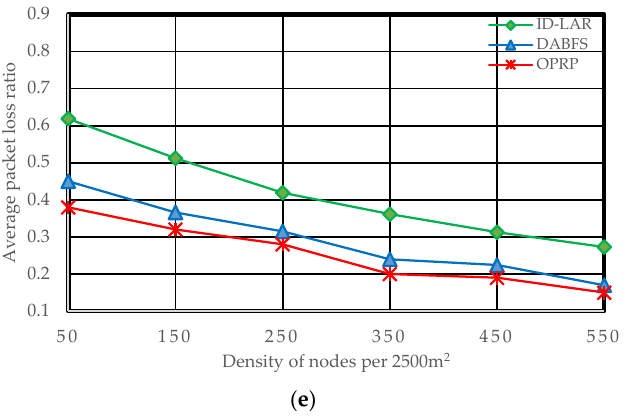
Figure 5. Average packet loss rate during the dissemination of WM. ( a ) Scenario 1: H (S, D) = 1, S is rear and D is front node. ( b ) Scenario 2: H (S, D) = 1, S is front and D rear. ( c ) Scenario 3: H (S, D) = 0, S and D are moving toward each other. ( d ) Scenario 4: H (S, D) = 0, S and D are moving away from each other.( e ) Scenario 5: H(S, D) = 0, S and D are moving toward each other.